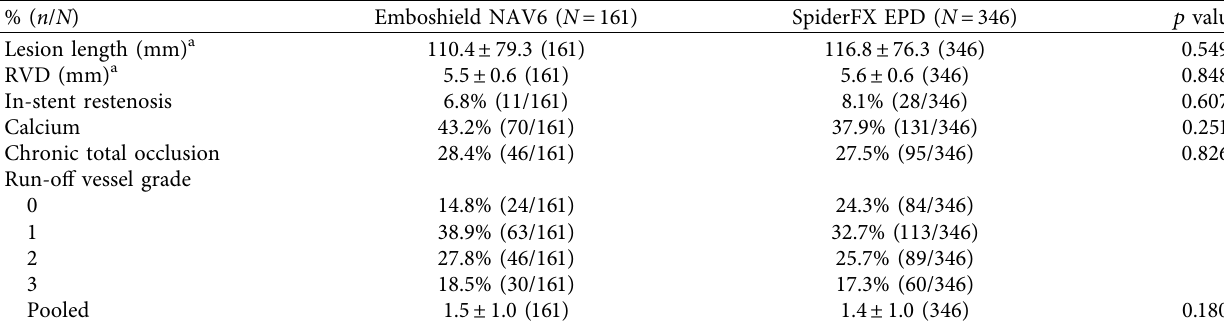
Table 2: Baseline lesion